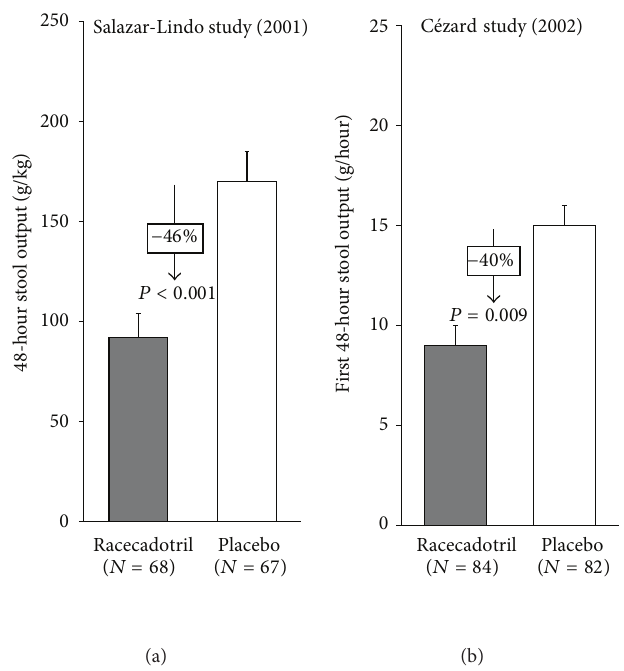
Figure 4: Efficacy of racecadotril at reducing stool output in two randomised placebo-controlled